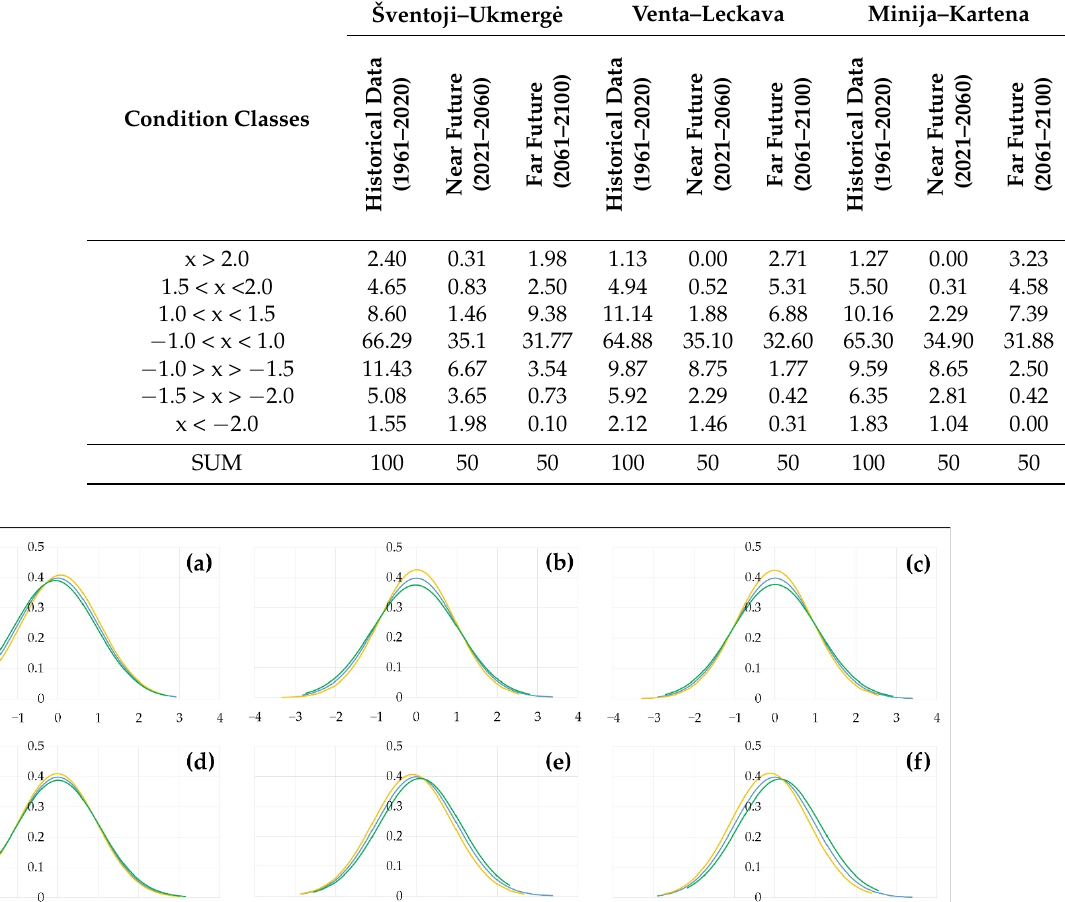
Table 6. Changes of SPI (x in Table) according to RCP 8.5.